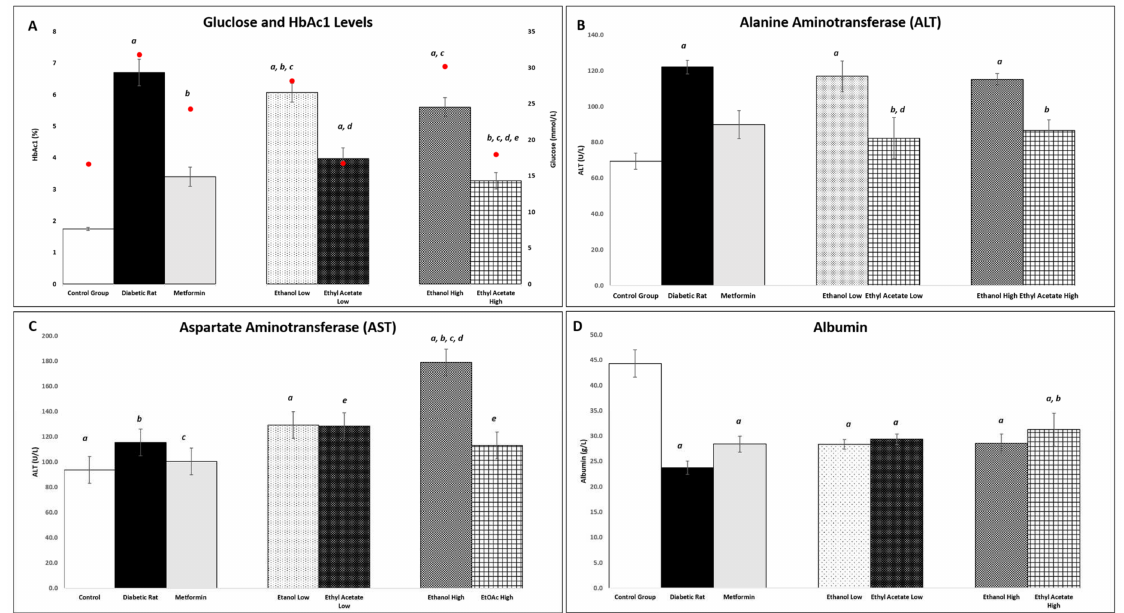
Figure 3. Effect of P. tetrastromatica extracts on plasma glucose and HbA1C levels ( red dot ) ( A ), alanine aminotransferase (ALT) ( B ), aspartate aminotransferase (AST) ( C ) and albumin ( D ) after 18-day treatment. (Note: For each group, high represents 400 mg kg − 1 dose, and low represents 200 mg kg − 1 dose of the respective extract. Significant differences ( p < 0.05) were observed between groups and is indicated with the following letters; a —against Control group, b —against Diabetic group, c —against metformin administered group, d —against Ethanol low administered group, e —against Ethanol high administered